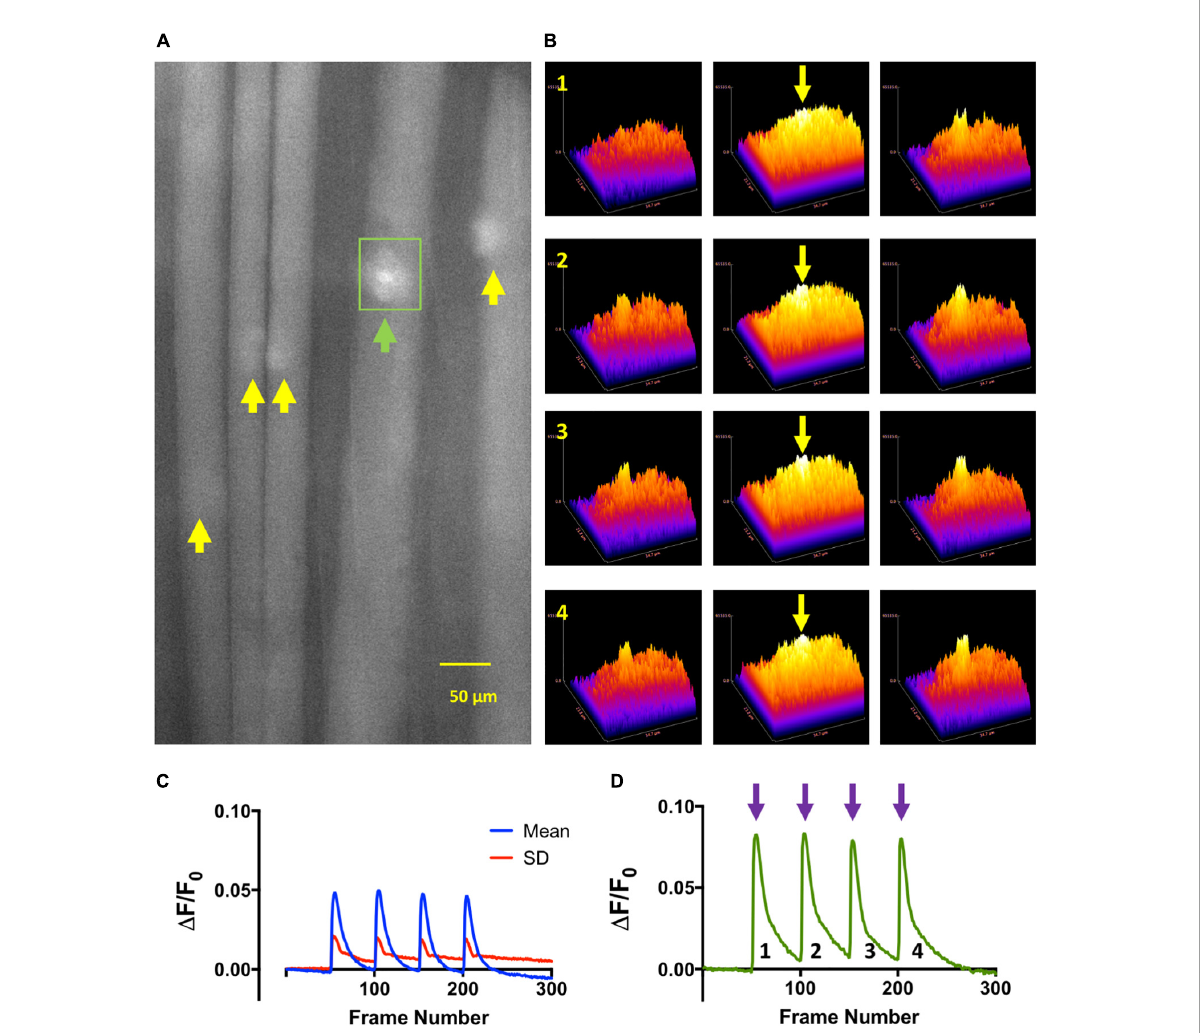
FIGURE3 Train of Four (TOF) stimulation of NMJs in omethoate evokes local increases in endplate Ca 2 + . (A) Image of a mouse FDB muscle fibers loaded with the Ca 2 + indicator Fluo-4AM and following incubation ( > 1 h) in 150 µ M omethoate, at the peak of the twitch responses to each stimulus during train-of-four (TOF) stimulation at 2 Hz. Images were captured at 100 frames per second (fps). Fluo4 (Ca 2 + ) signals were discernible only at the NMJs (arrows). (B) Three-dimensional surface plots of fluorescence from the local vicinity of the endplate indicated by the green arrow and rectangular region of interest outlined in panel (A) (see Supplementary Video 2 ). Rows 1–4 show endplate fluorescence associated with successive responses to TOF stimulation. The middle columns (yellow arrows) show images taken at the peak of the responses, the column on the left show images immediately before stimulation and the column on the right the responses 200 ms after the peak of the response. (C) Mean (blue line) and standard deviation (red) of fluorescence increases ( (cid:49) F/F 0 ) in the endplate regions of the muscle fibers ( n = 5 endplates) indicated by the arrows in panel (A) . (D) Increase in fluorescence ( (cid:49) F/F 0 ) with each successive stimulus in the TOF for the endplate indicated by the green arrow in panel (A) and also corresponding to the surface plots shown in panel (B)